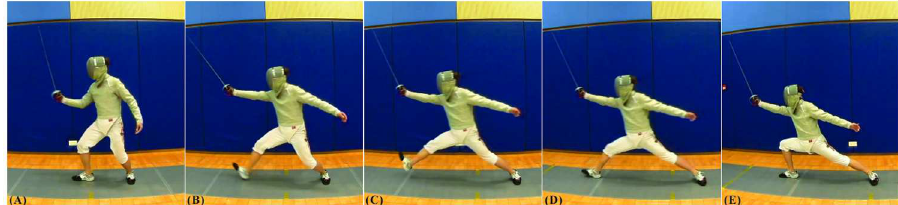
Fig 2. Sequence of movement for lunging using a saber fencer. (A) on-guardposition; (B) lifting of the lead leg; (C) forward flying phaseof the lead leg and push-off with the trail leg; (D) landingof the leadfoot with the armed upper limb in full extension;and (E) final lunge